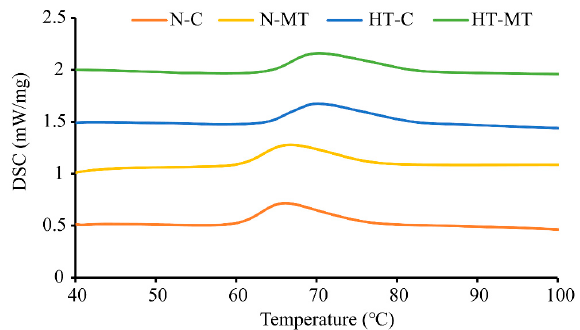
Figure 6. DSC analysis of NPB treated with exogenous substances under normal and high temper- ature. The data presented in the figure are repeated through three independent experiments. “N” and “HT” indicate normal and high temperature conditions. “C” and “MT” indicate H 2 O and mel- atonin treatment, respectively.